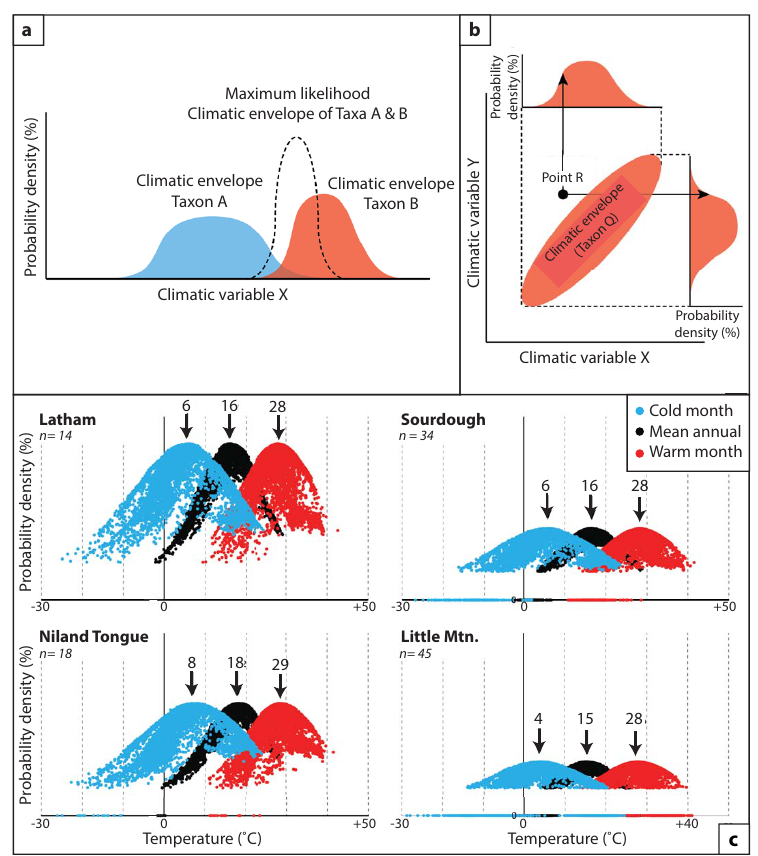
Figure 3. Floral methods description. (a) Probability density functions of hypothetical Taxa A and Taxa B along climatic variable X to form a probability density function representative of the maximum likelihood of co-occurrence. (b) Hypothetical climatic envelope of Taxon Q with climatic variables X and Y , where point R occurs outside the envelope of Taxon Q but within its range of both variables (creating a false inclusion of point R). (c) Probability density function distributions for seasonal temperatures from sampled paleofloral sites, where arrows indicate calculated mean temperatures for each parameter, and n is the number of morphotypes included in each